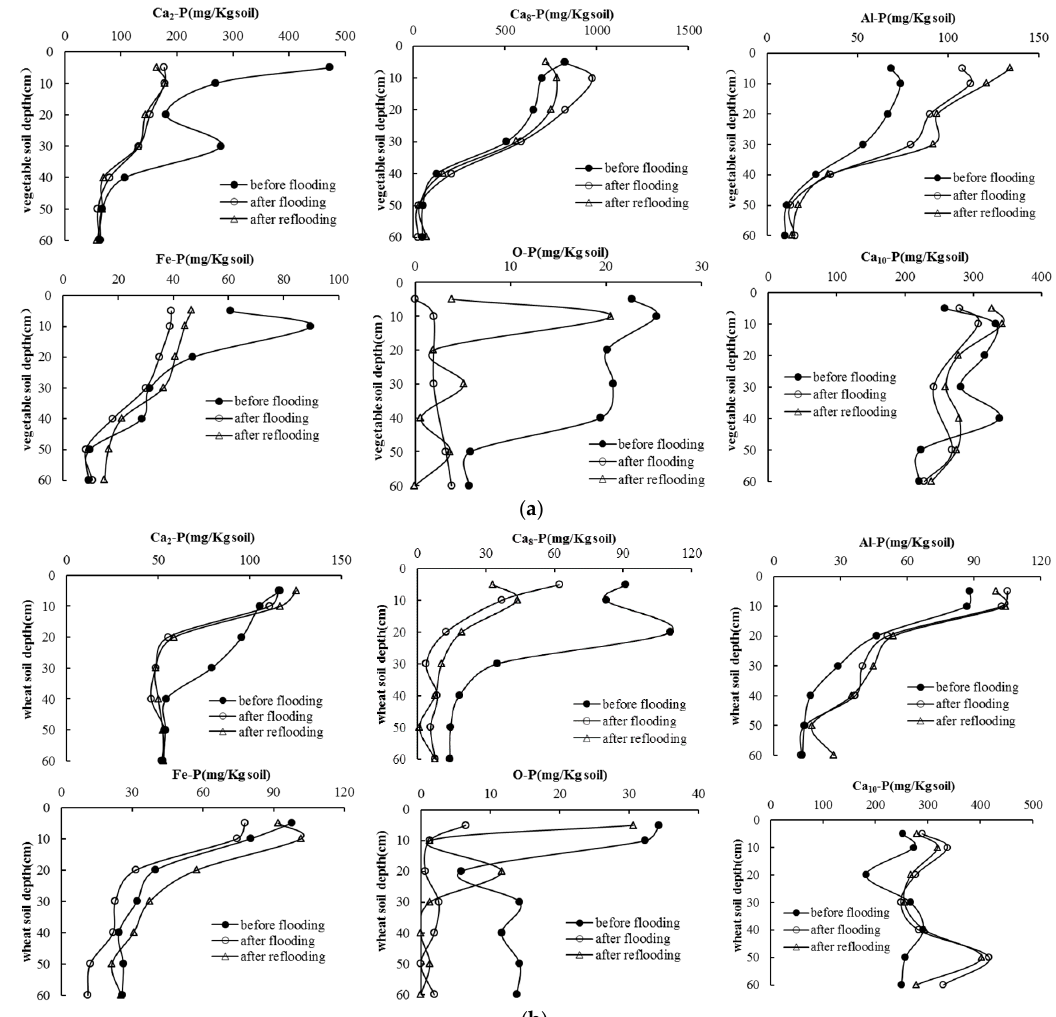
Figure 5. Inorganic phosphorus fractions in different soil layers (( a ) VS; ( b ) WS).